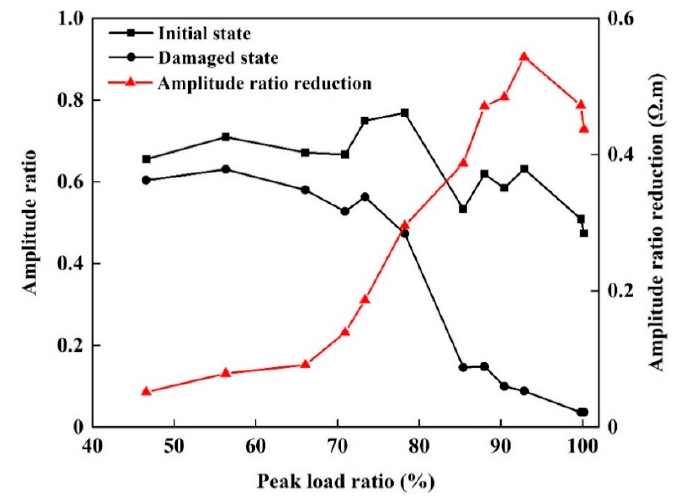
Figure 9. First wave amplitude attenuation for sandstone specimens before and after damage.